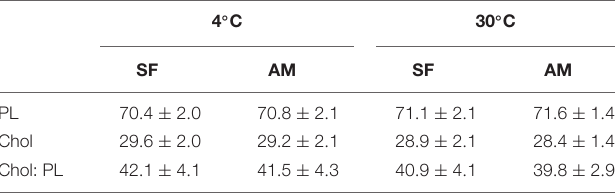
TABLE 3 | Proportions (%) of total phospholipid (PL), total cholesterol (Chol), and Chol: PL in Lota lota spermatozoa diluted in seminal fluid (SF) and activation medium (AM) at different temperatures.